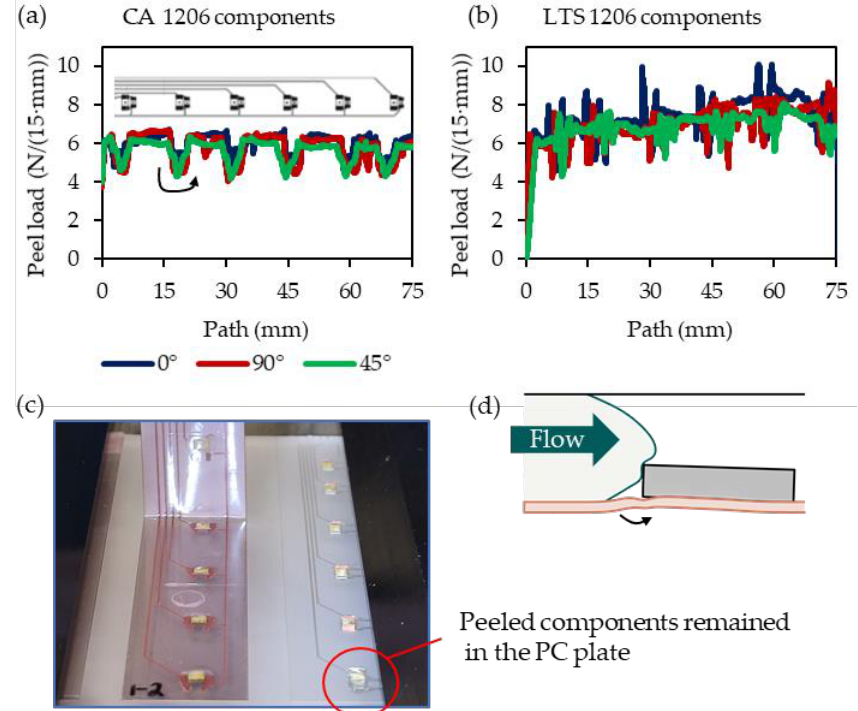
Figure 15. Peel force of the film strips cut from overmolded foils comprising components using low conductive adhesive ( a ) and low-temperature solder ( b ). All peeled components remained in the PC substrate ( c ). Similar load cases might occur during overmolding when the flexible foil potentially bends during overmolding ( d ).